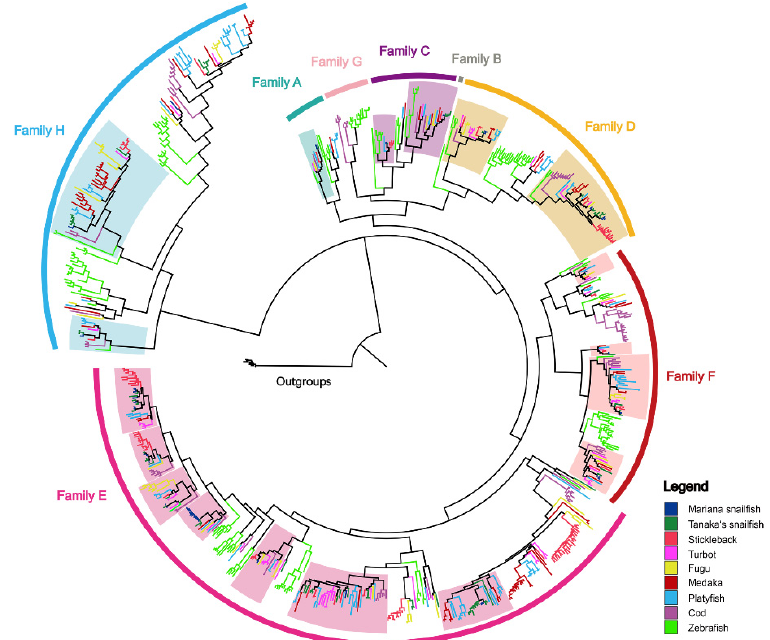
Figure 2. A phylogenetic tree of ORs from nine fish species (legends are indicated on the right side of the figure). Melanocortins from seven teleosts were used as an out ‐ group. The orthologous groups containing the Mariana snailfish and Tanaka’s snailfish ORs are indicated by shading.